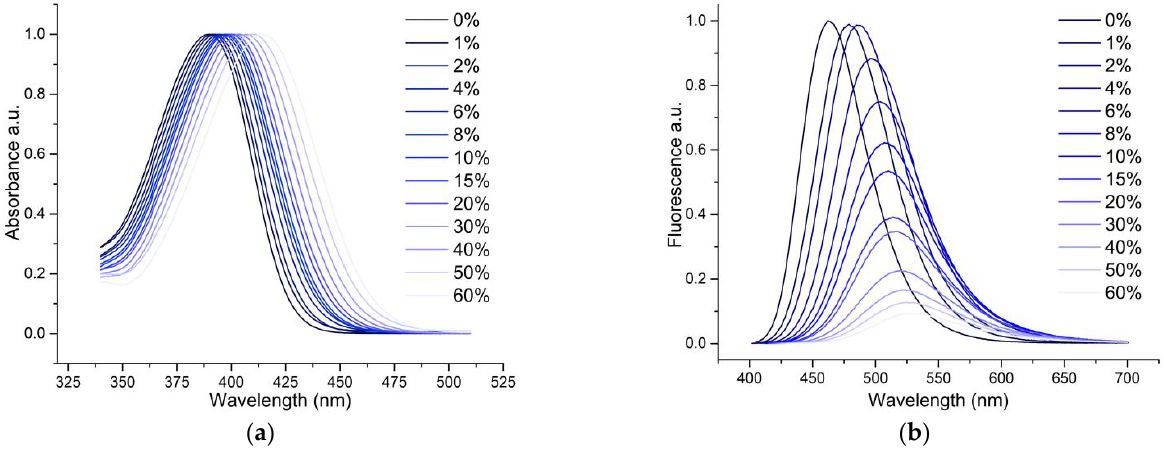
Figure 3. Absorption ( a ) and fluorescence ( b ) responses of AlMF to hydration. Data were recorded in gradual mixtures of water in THF.